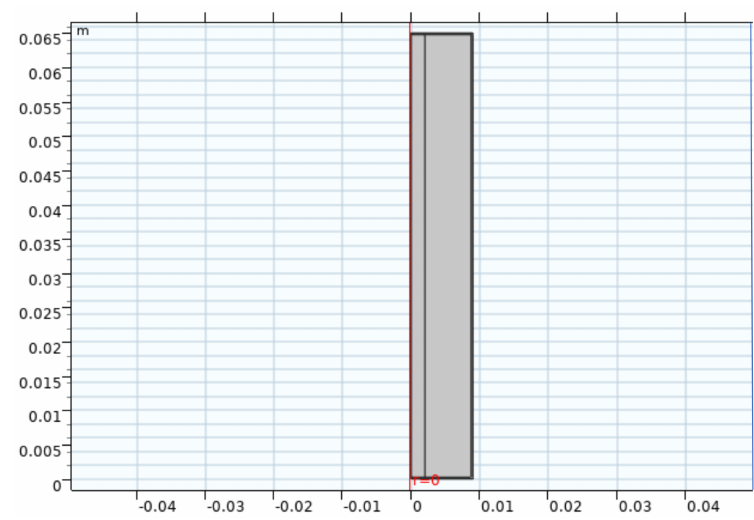
Figure 2. Two-dimensional axial-symmetric geometry. Table 2. Two-dimensional cell component size.